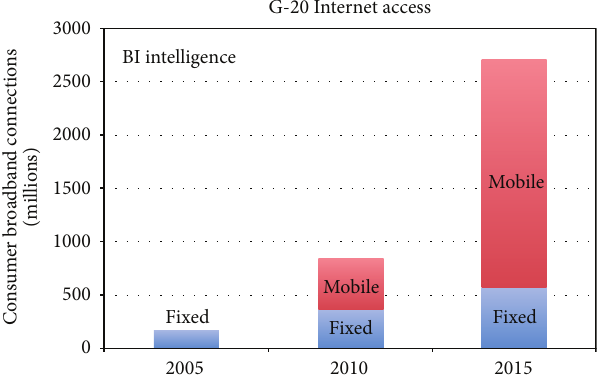
Figure 6: Global Internet connections in